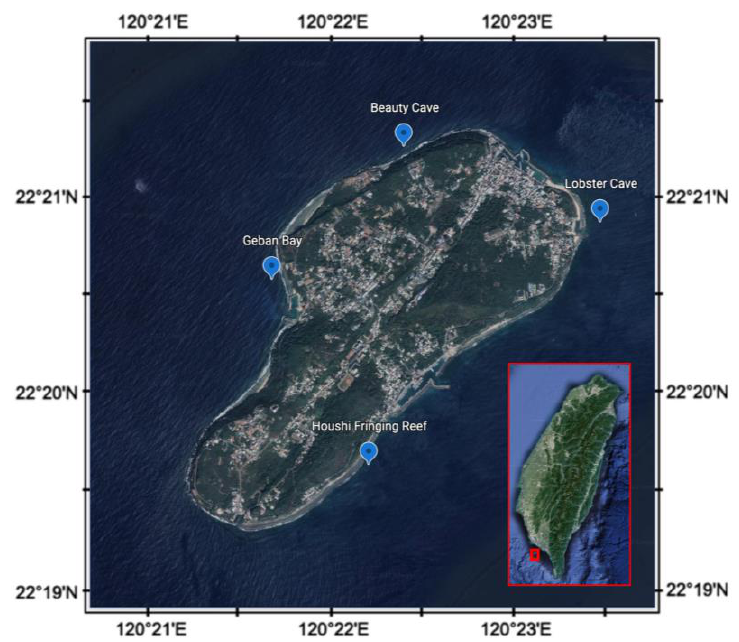
Figure 1. Sampling sites of coral reef areas around Liuqiu Island, southwestern Taiwan.